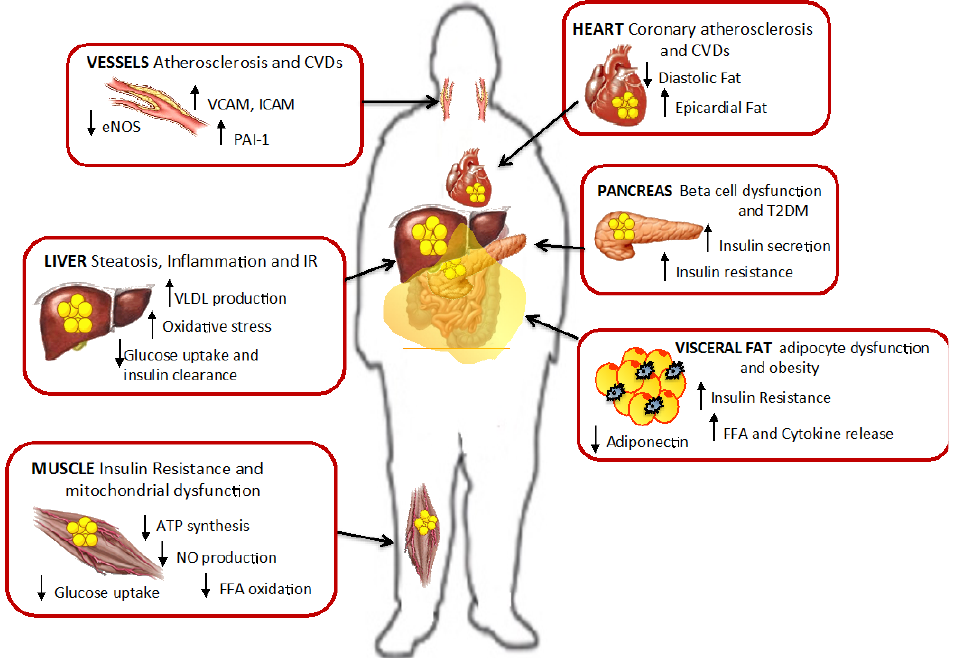
Figure 6. Ectopic fat accumulation and effect of lipotoxicity. Fat accumulation in non-adipose tissues promotes cell dysfunction, insulin resistance and inflammation in liver, muscle, pancreas and visceral fat. Also in vessels and heart lipotoxicity leads to increased risk for cardiovascular diseases and atherosclerosis. Modified from Gaggini M. et al. [2].